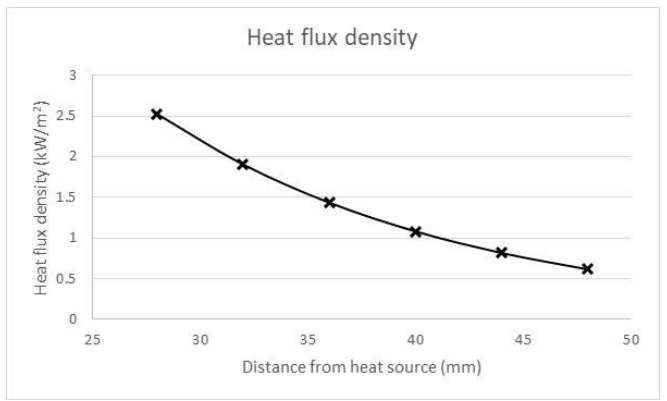
Figure 13. Heat flux density vs. distance between heat source and sample in testing stage.